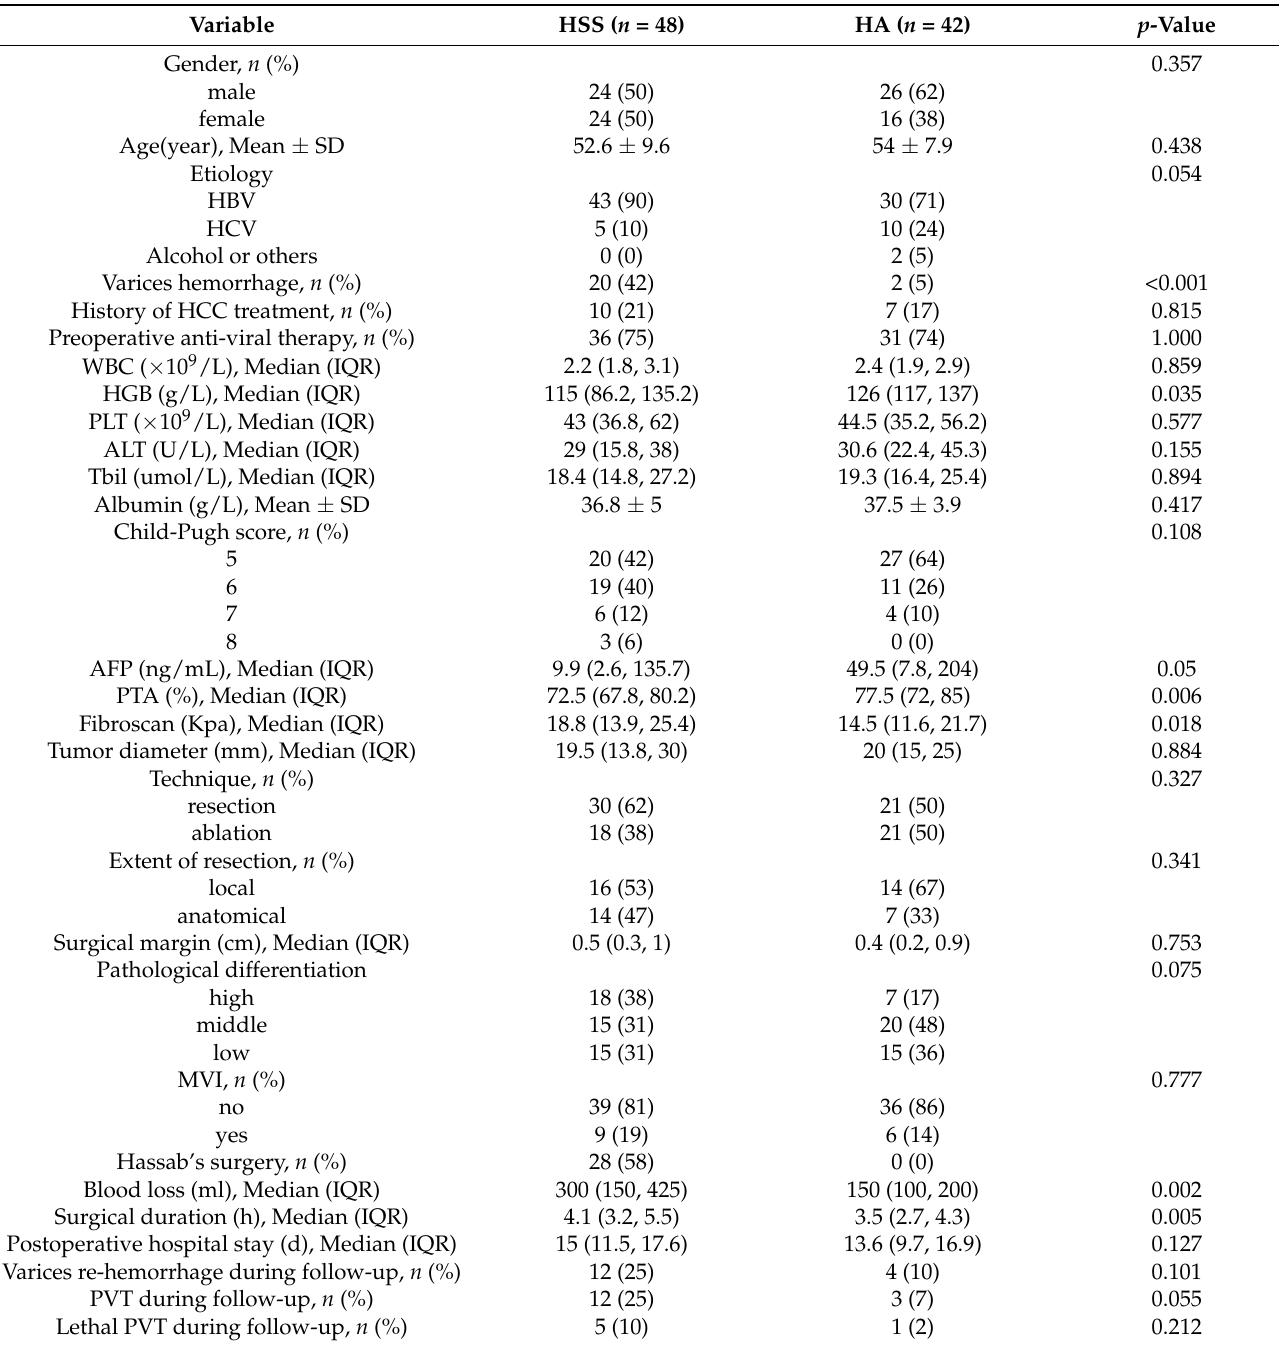
Table 2. Baseline characteristics and perioperative data of stage T1 HCC treated with radical treatment with synchronous splenectomy (HSS group) compared with radical treatment alone (HA